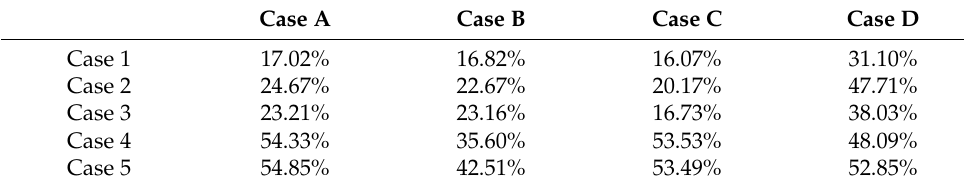
Table 4. Errors of the estimated road roughness using the directly estimated FRF.